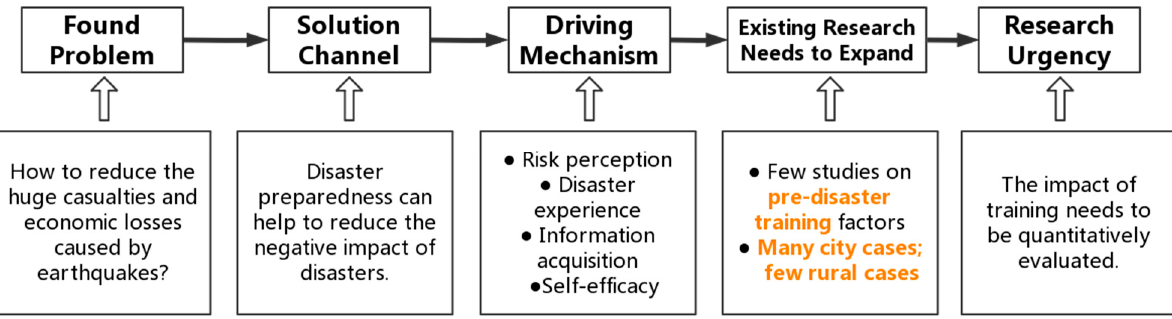
Figure 1. Source of research ideas.